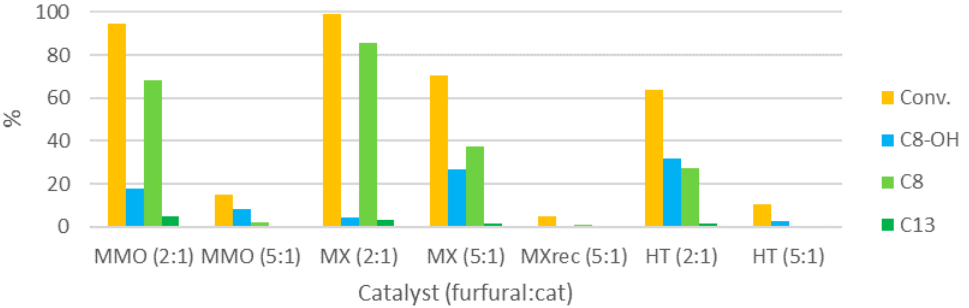
Figure 9. Influence of the catalyst choice (at 100 °C, 10 min, 0.21 M).